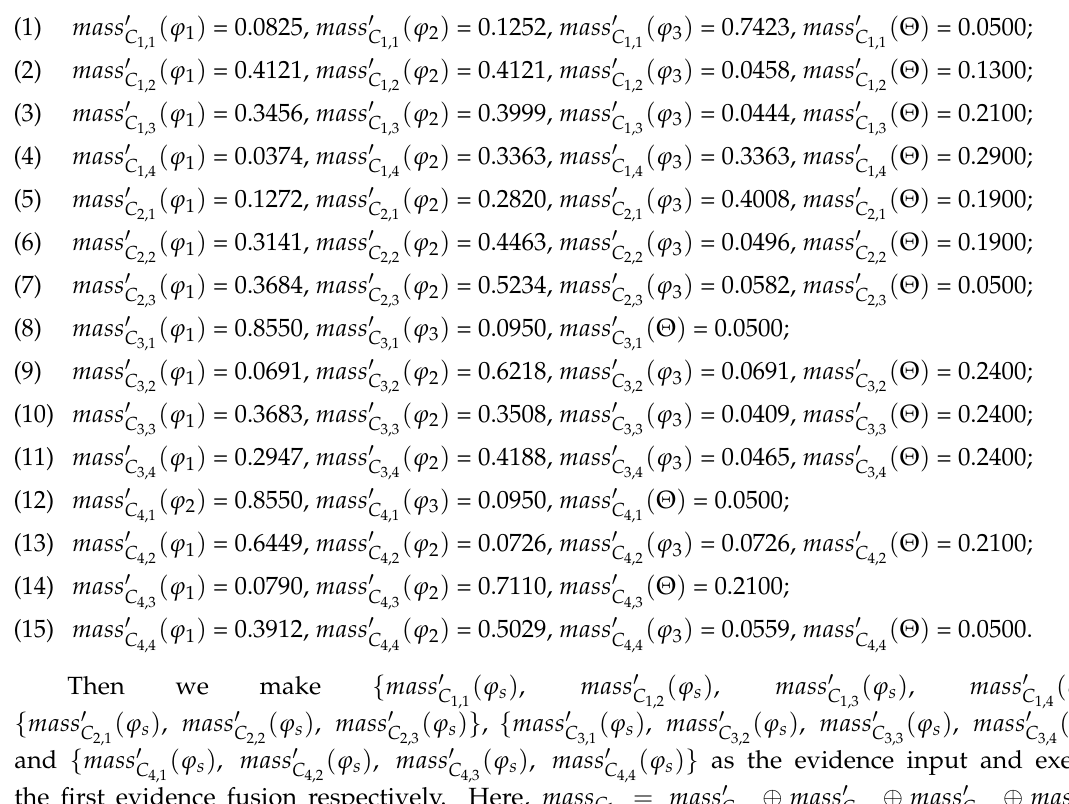
The basic probability distribution